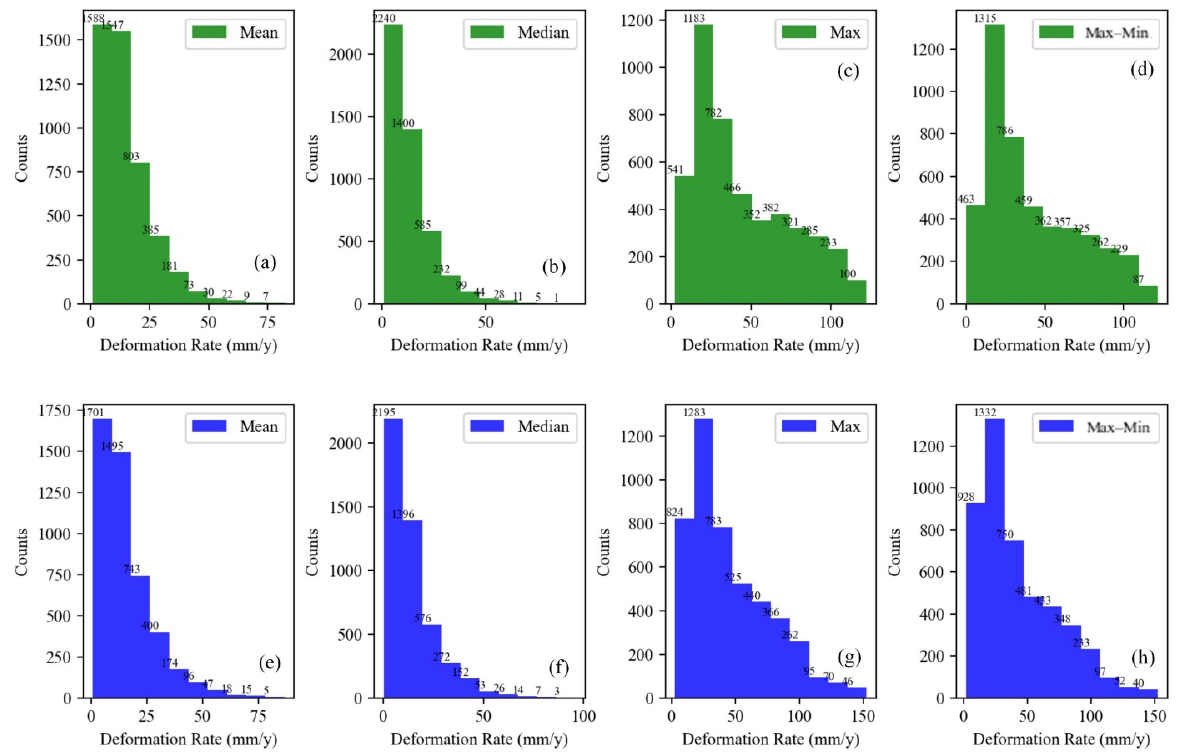
Figure 10. The distribution statistics of rock glacier deformation characteristics in ascending and descending geometries. ( a – d ) Mean, median, maximum, and difference between the maximum and minimum deformation in the ascending geometry. ( e – h ) Mean, median, maximum, and difference between the maximum and minimum deformation in the descending geometry.